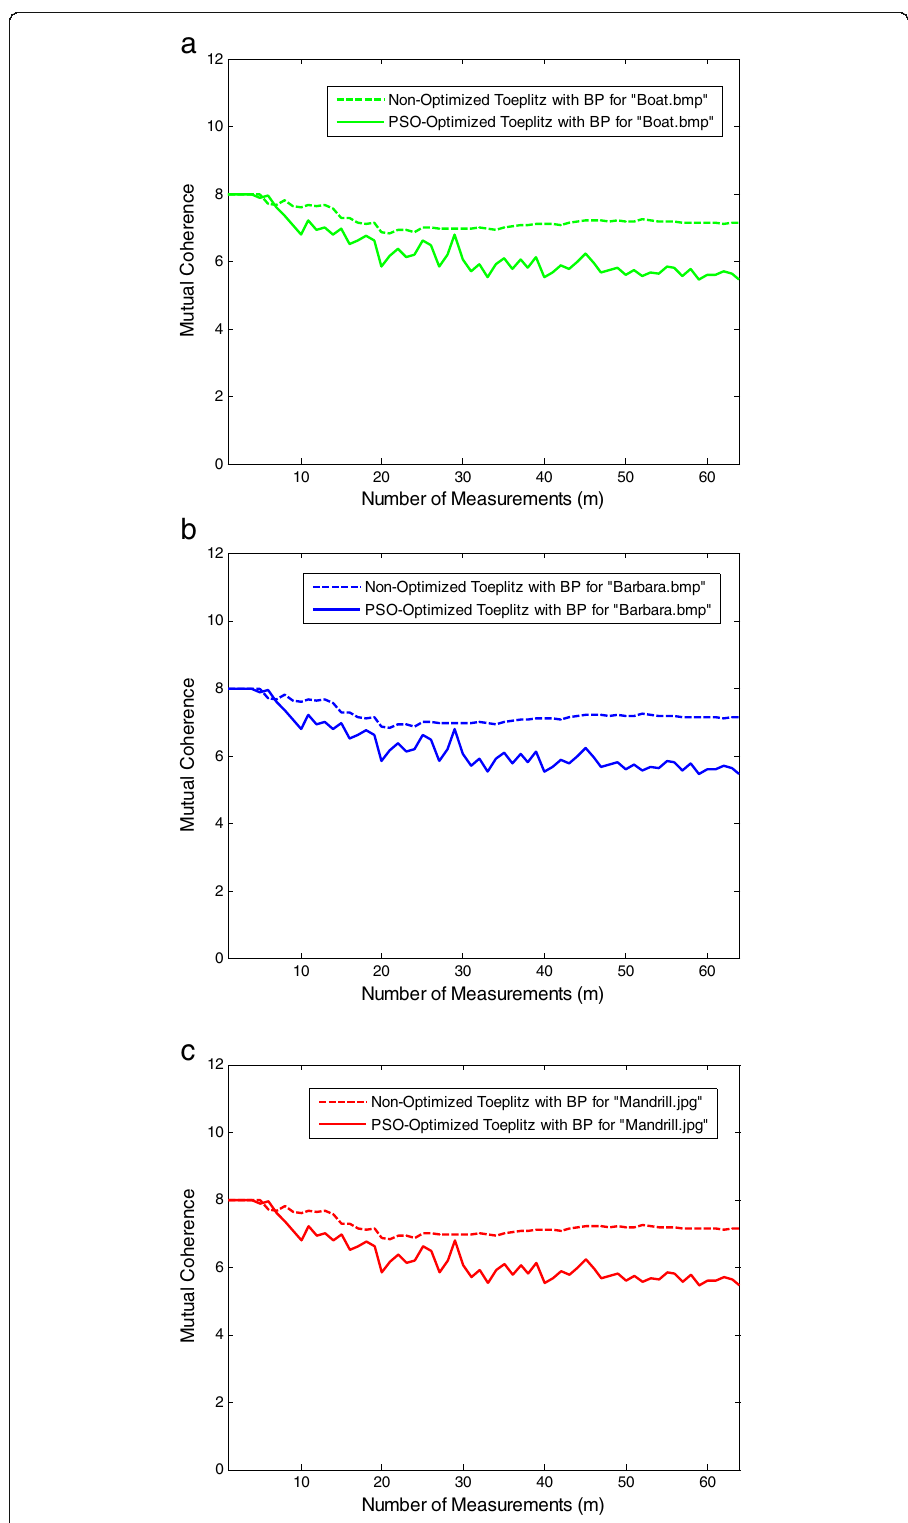
Fig. 12 a The mutual coherence ( μ ) of proposed PSO-optimized Toeplitz sensing matrix for different values of measurements (m), for “ Barbara.bmp ” image. b The mutual coherence ( μ ) of proposed PSO-optimized Toeplitz sensing matrix for different values of measurements (m), for “ Barbara.bmp ”